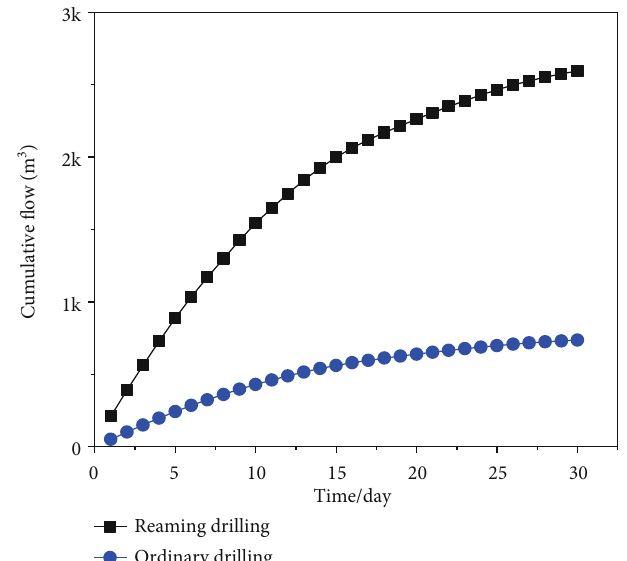
Figure 11: Contrast curve of the cumulative extraction scalar volume between a single-reamed borehole and a single-unreamed conventional borehole for 30 consecutive